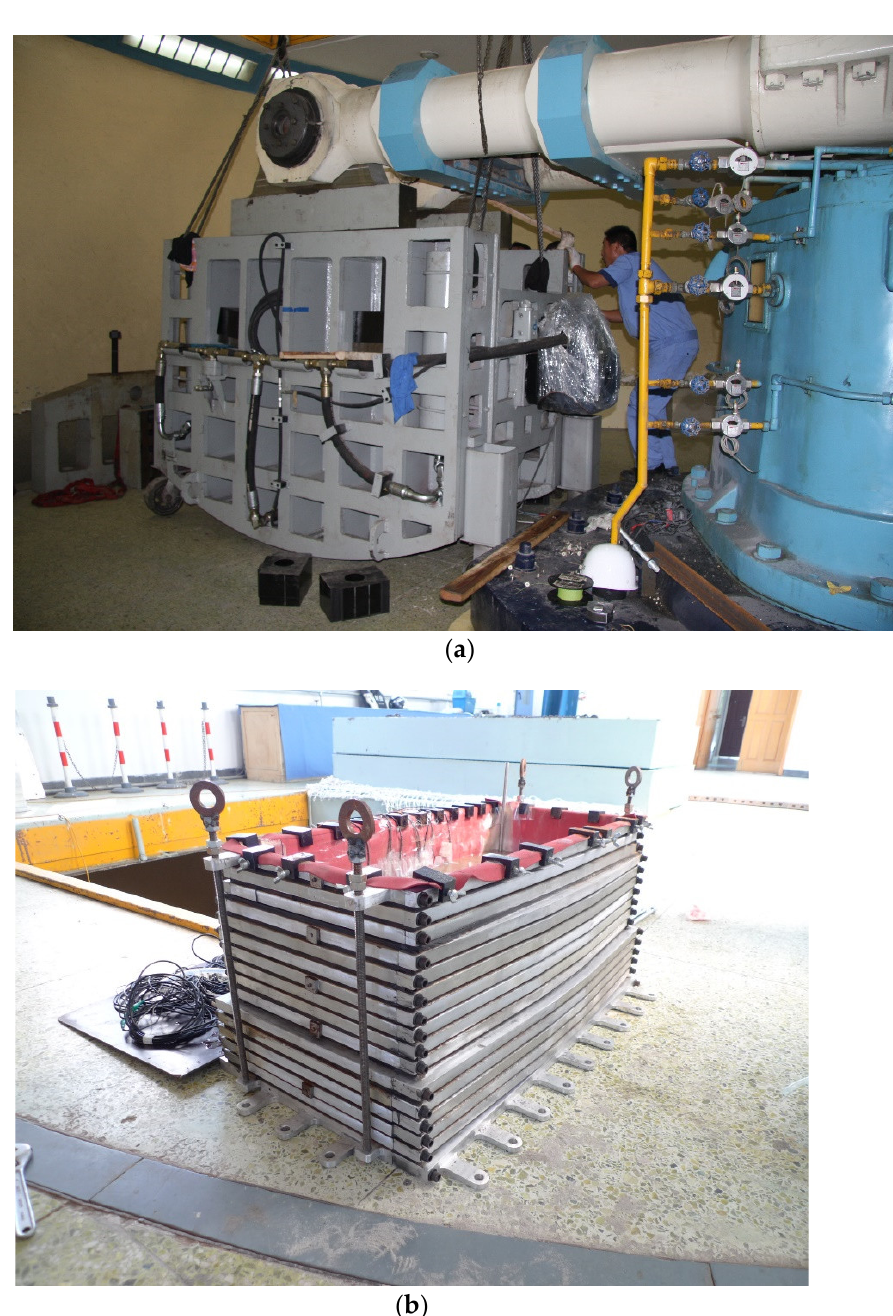
Figure 2. Geotechnical centrifuge and model box. ( a ) Lxj-4-450 geotechnical centrifuge with vibrating table. ( b ) ESB equivalent shear model box.